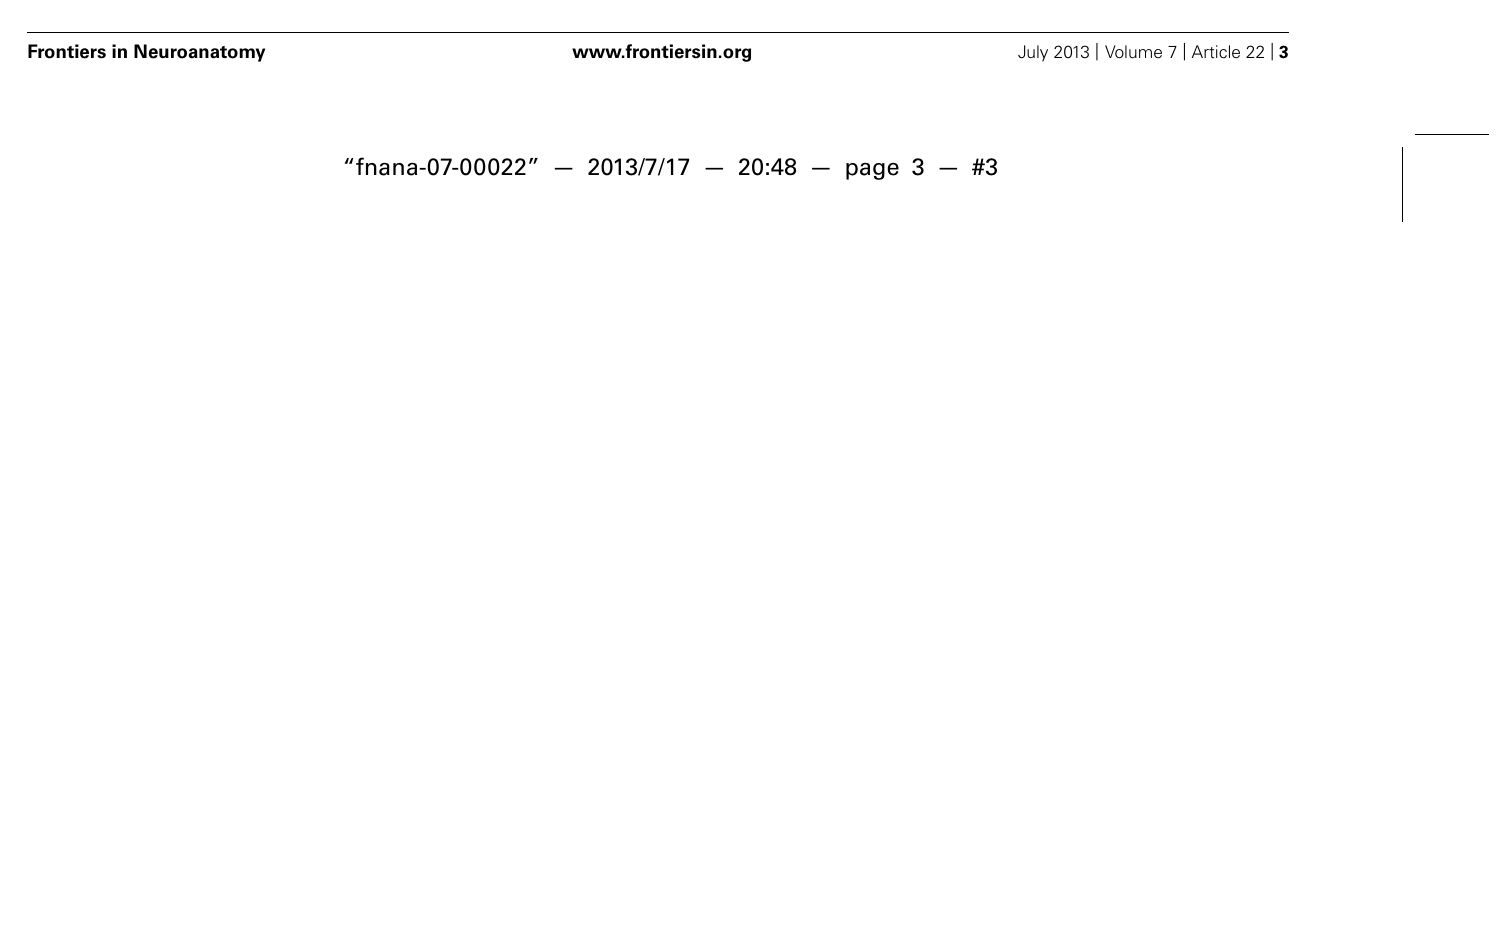
notolegia). (B) Atlantogenata (Afrotheria and Xenarthra) as sister lineage of Boreoeutheria (Euarchontoglires and Laurasiatheria). (C) Xenarthra as the most basal clade, sister lineage of Epitheria (all other